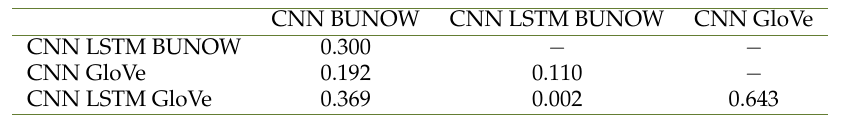
Table 4. Results of Paired comparisons.